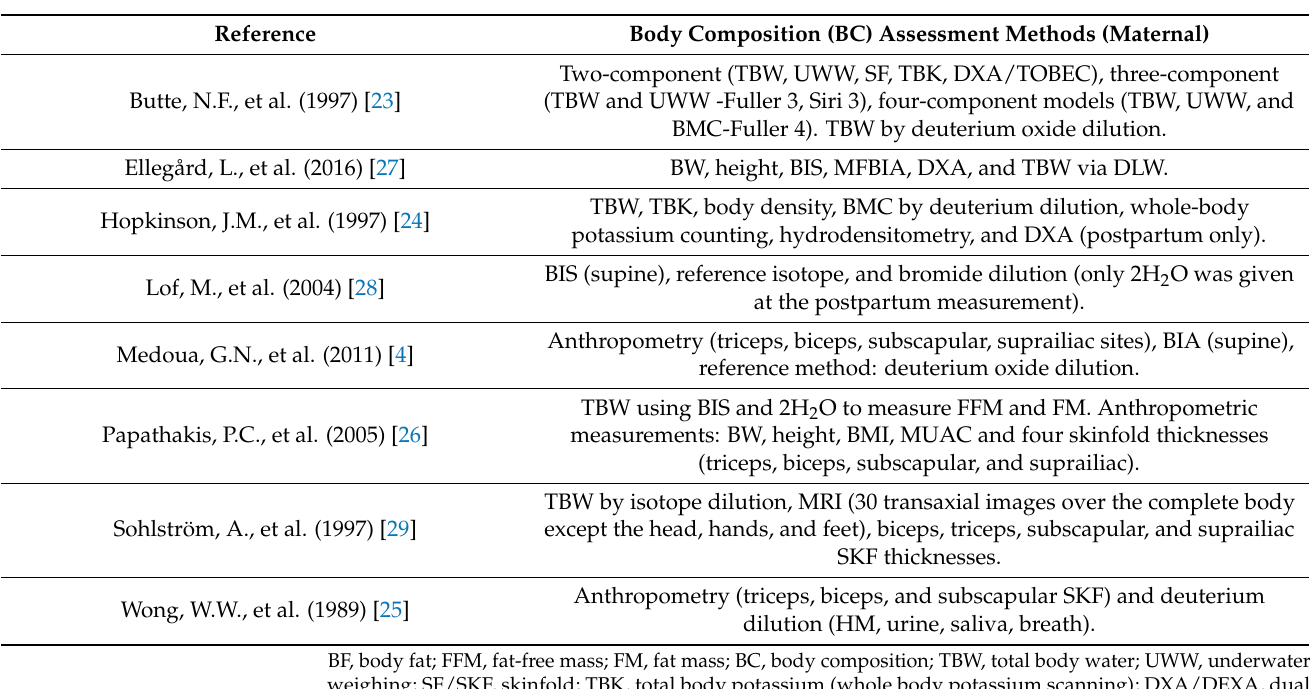
Table 1. Body composition assessment techniques used in the included